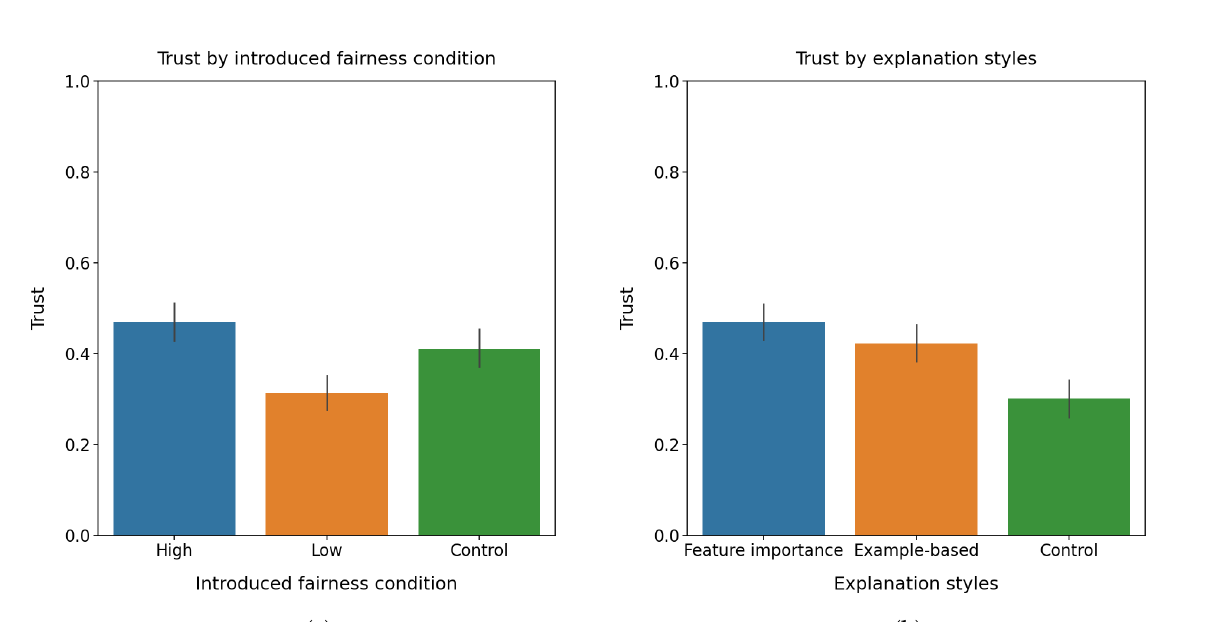
Figure 3. User trust over fairness and explanations. ( a ) User trust under introduced fairness condi- tions. ( b ) User trust under explanation